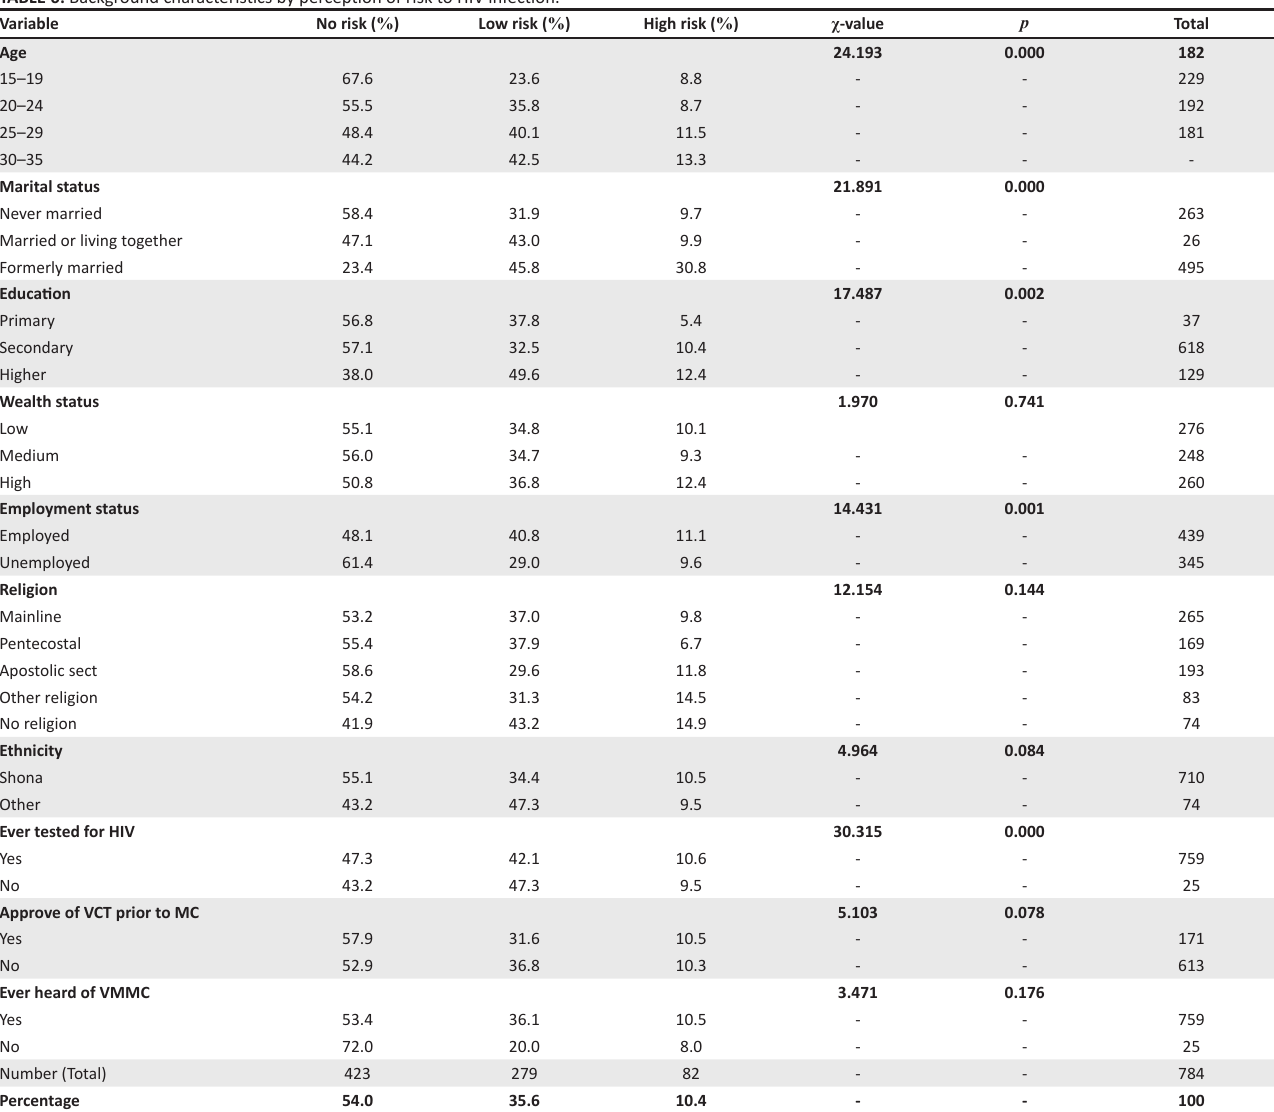
TABLE 6: Background characteristics by perception of risk to HIV infection.